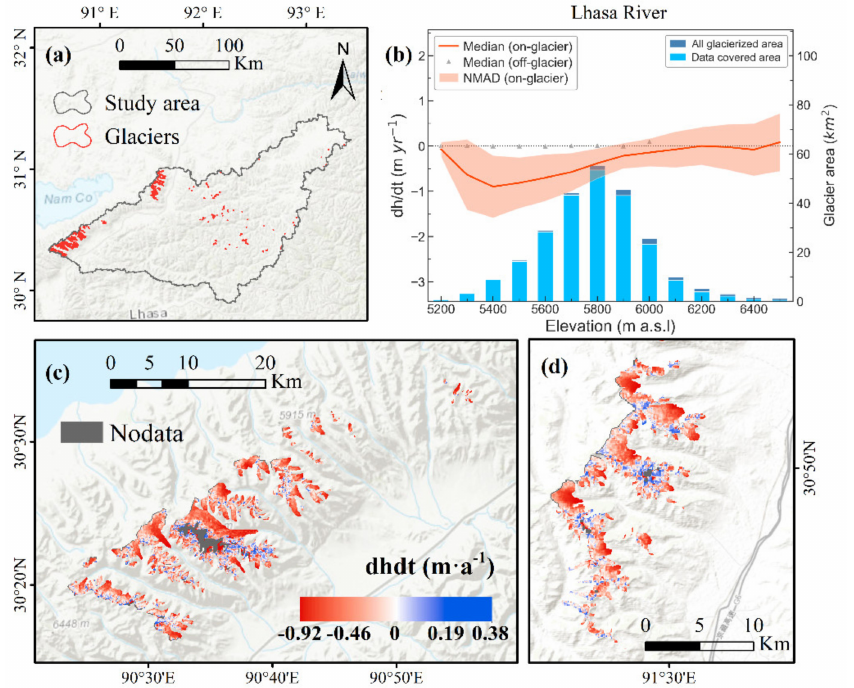
Figure 4. Changes in ( a ) the annual elevation and ( b ) the annual glacier elevation in the study area, and ( c , d ) the glacier elevation changes in relation to the elevation (m a.s.l.) derived from differentiating the TanDEM-X and SRTM. Statistics are grouped in a 100-m elevation